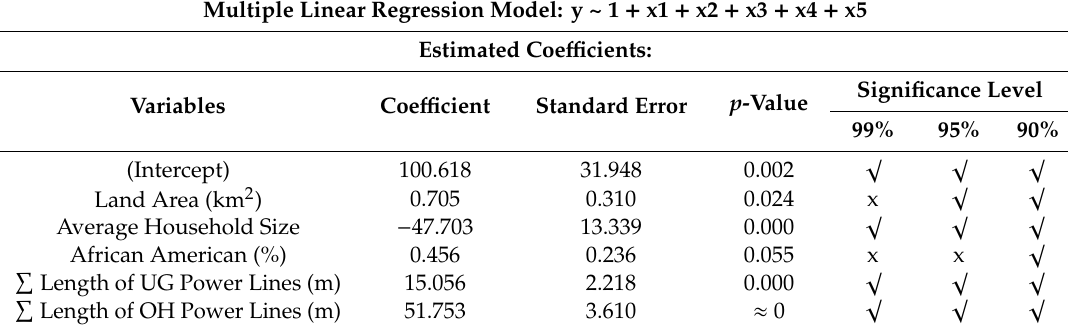
Table 3. Model results for Hurricane Michael-induced power